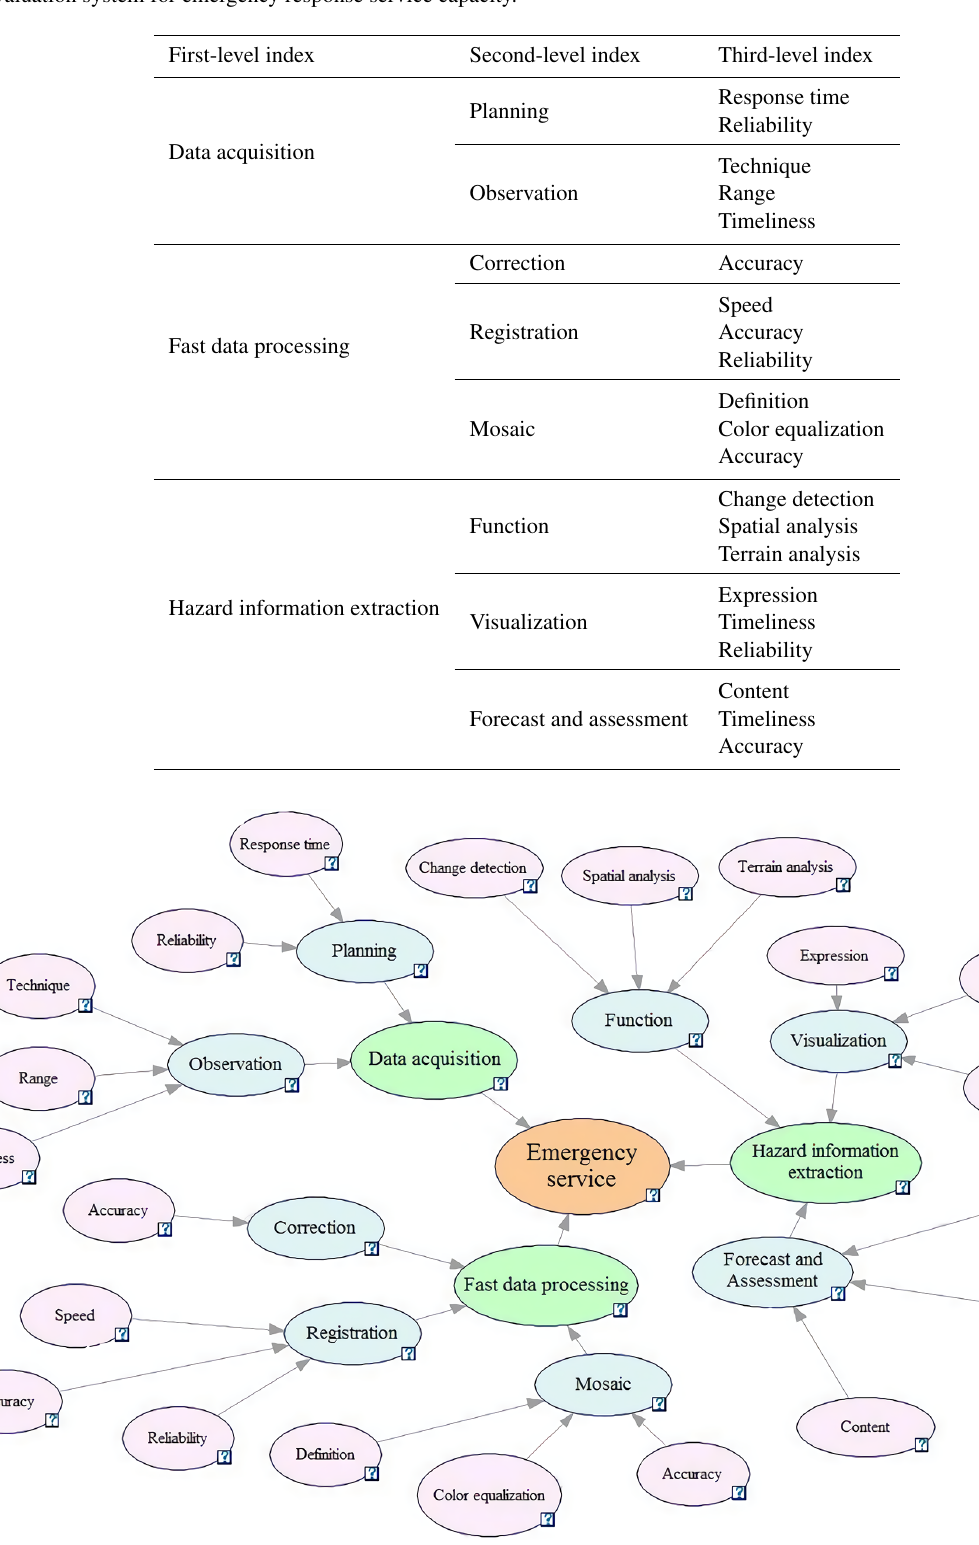
Figure 8. Bayesian network topology of service capacity evaluation